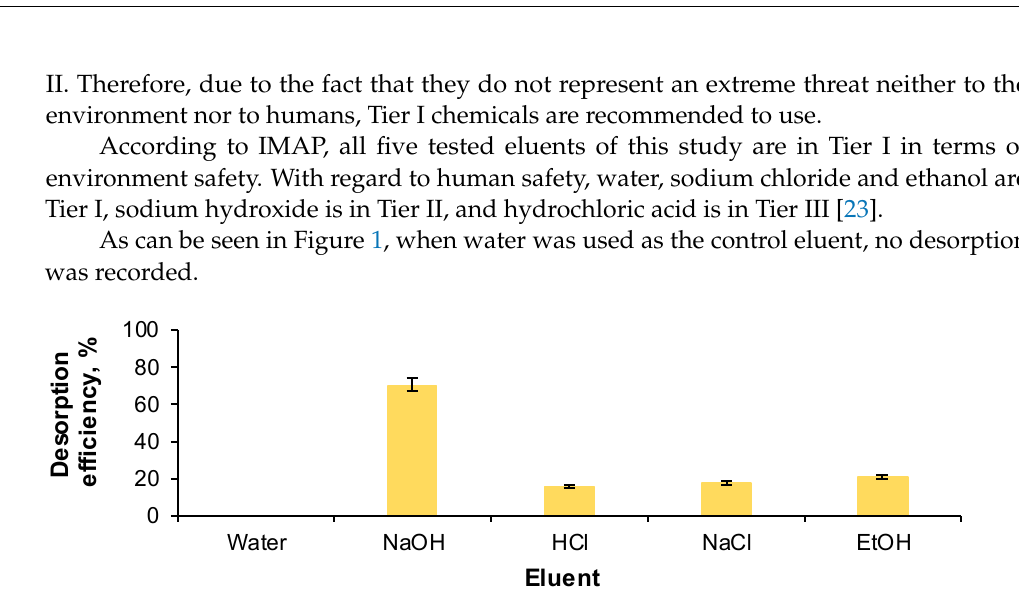
Figure 1. Impact of eluent type on the desorption efficiency of Reactive Black 5 dye from the prepared adsorbent (RB volume: 30 mL, RB initial concentration: 30 mg/L, eluent volume: 30 mL, eluent